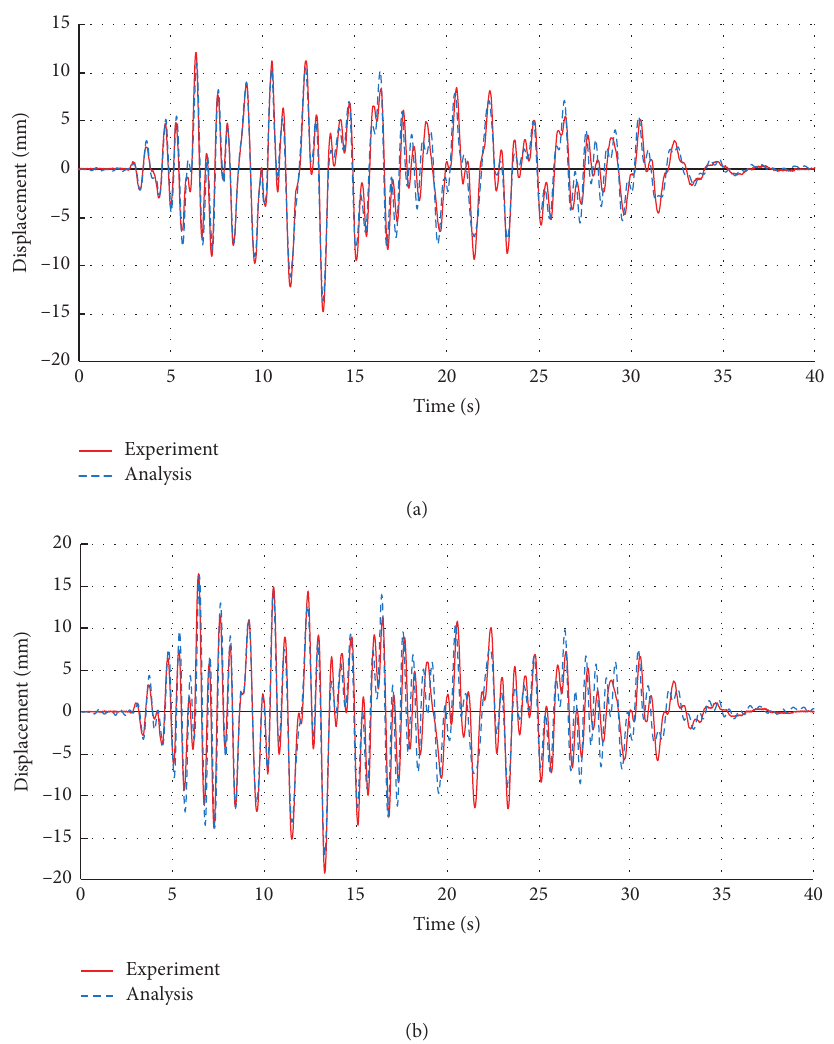
Figure 8: Comparison of the analytical and experimental [34, 71] history displacements. (a) Displacements of the 1 st storey. (b) Dis- placements of the 2 nd